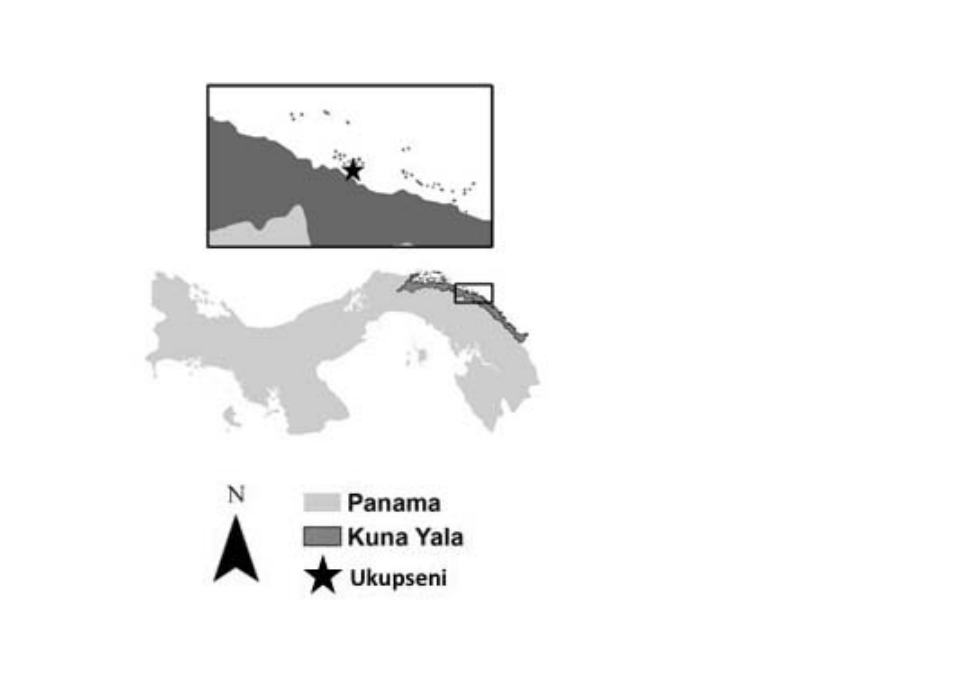
Fig. 1. Map of comarca Kuna Yala and the island of